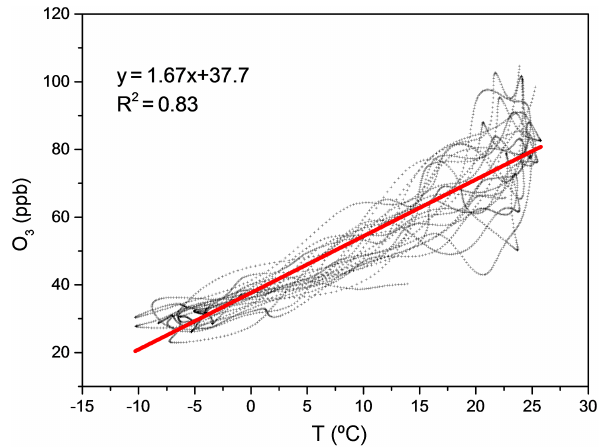
Figure 6. Linear regression fit on the filtered daily maxima of tem- perature and ozone. Temperature data are lagged by 17 days to ozone